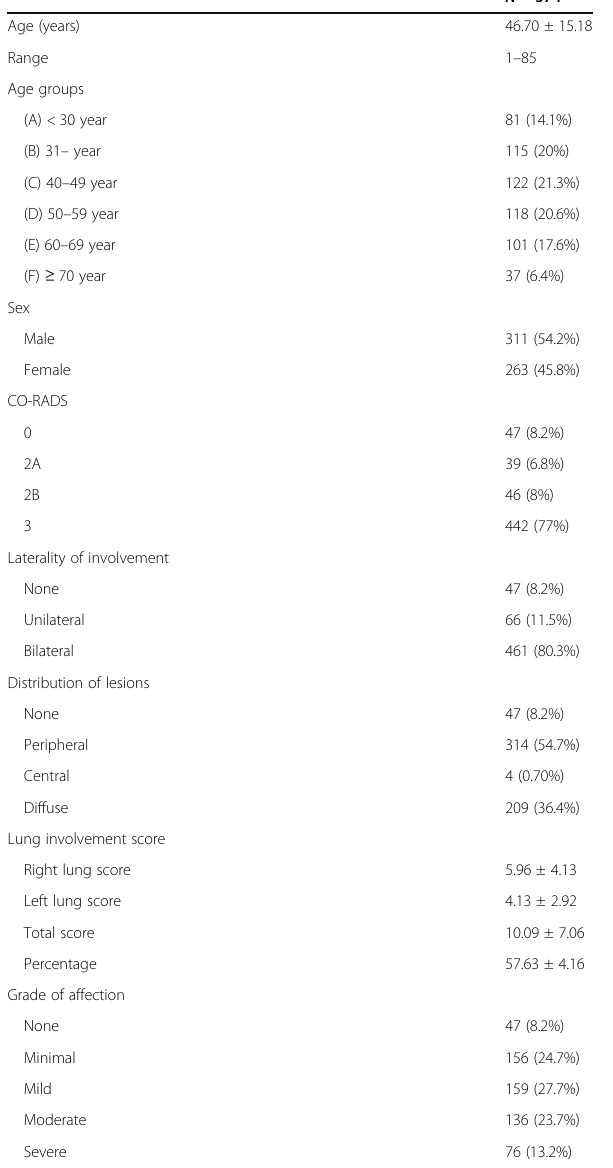
Table 2 Characteristics of the study population